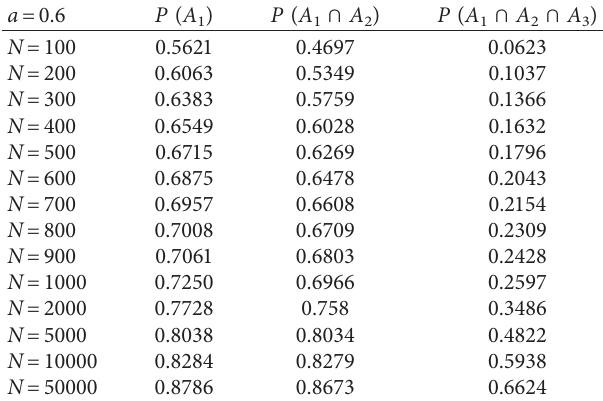
Table 2: Calculation accuracy of GPH long memory estimation under the optimal bandwidth